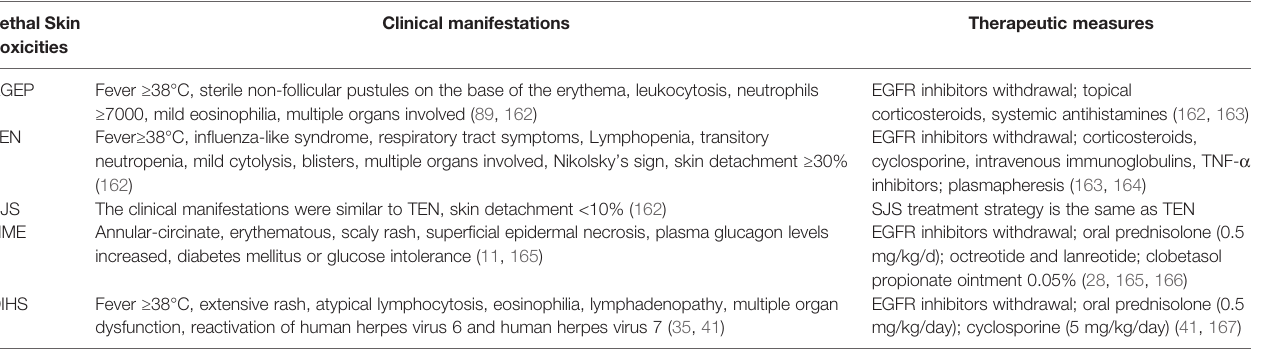
TABLE 6 | Clinical manifestations and therapeutic measures of severely fatal skin